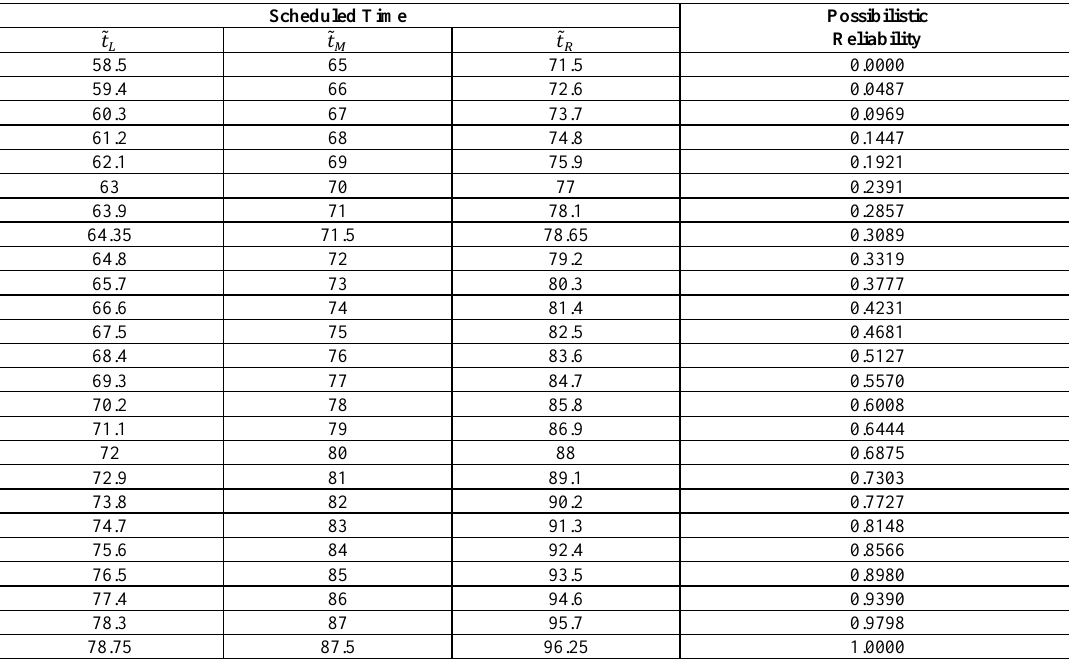
Table 4. Possibilistic reliability values (Second